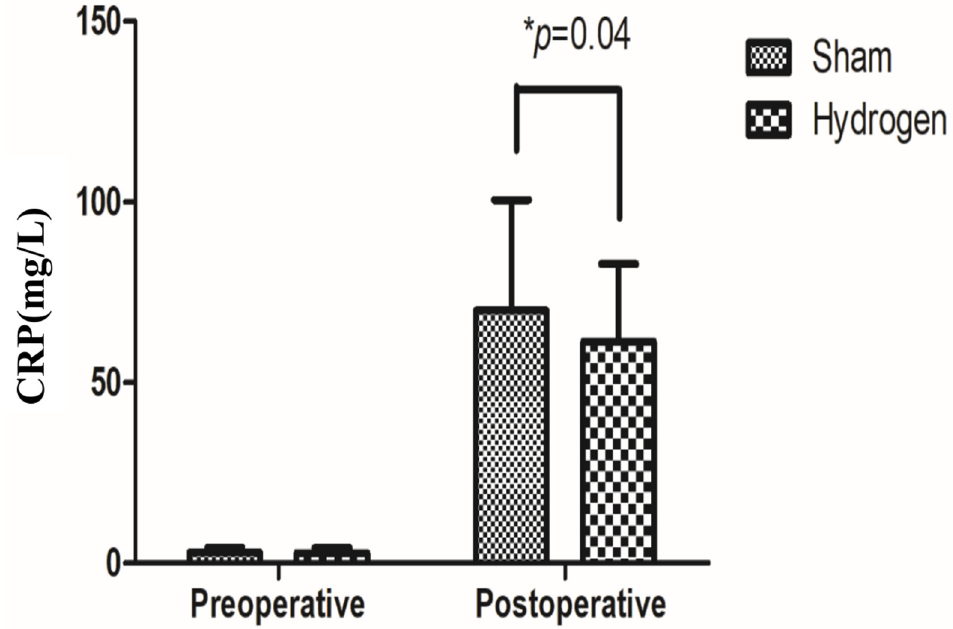
Figure 3. Pre- and postoperative CRP between the two groups. For statistical significance, * indicates p ≤ 0.05. CRP, C-reactive protein.